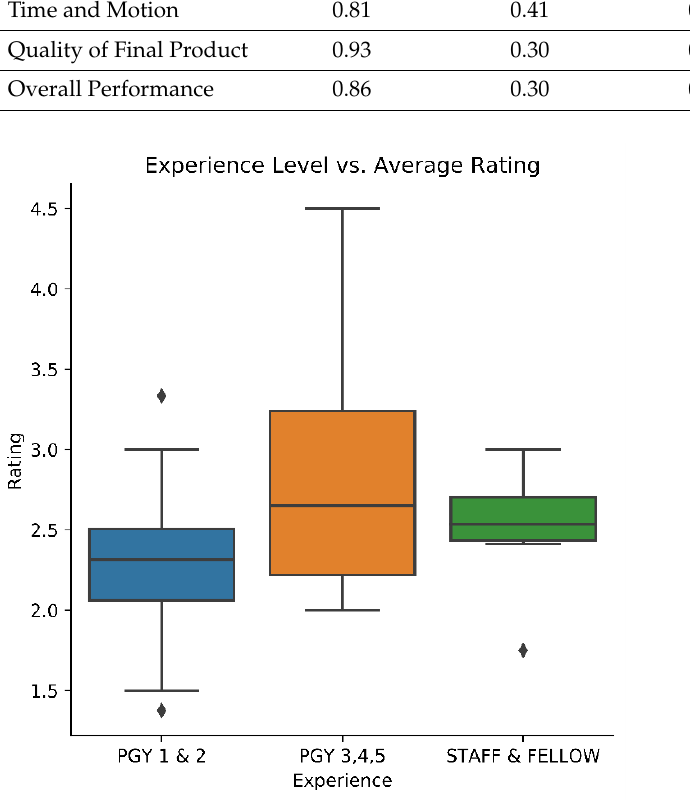
Figure 4. Participant experience and rating on the ‘Overall Performance’ domain. A significant difference was found between the Beginner and Intermediate